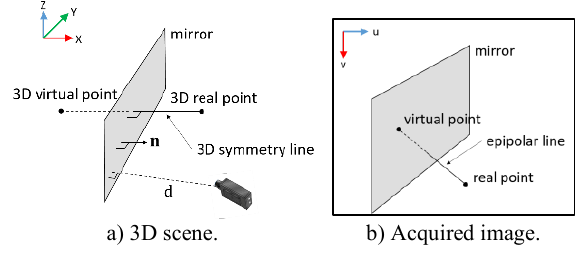
Figure 1: Real point mirrored in a planar mirror.